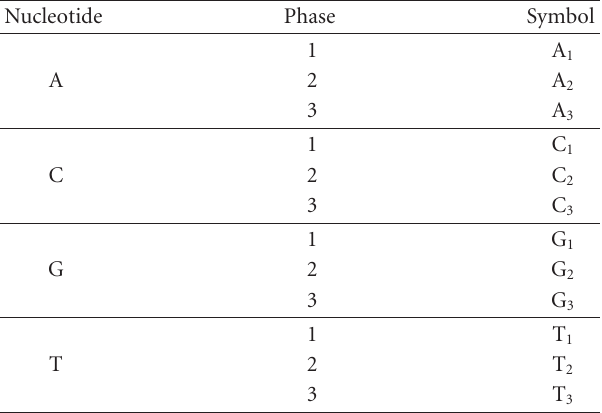
Table 2: Symbol mapping for 12-symbol alphabet. Nucleotide